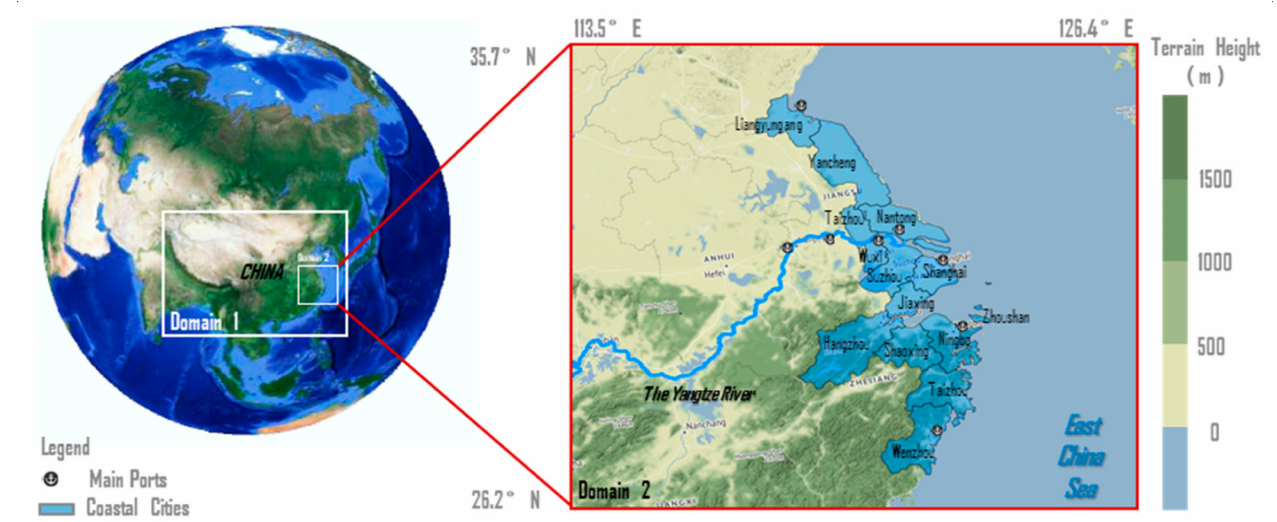
Figure 1. Sketch map of the study area and two nested domains established for